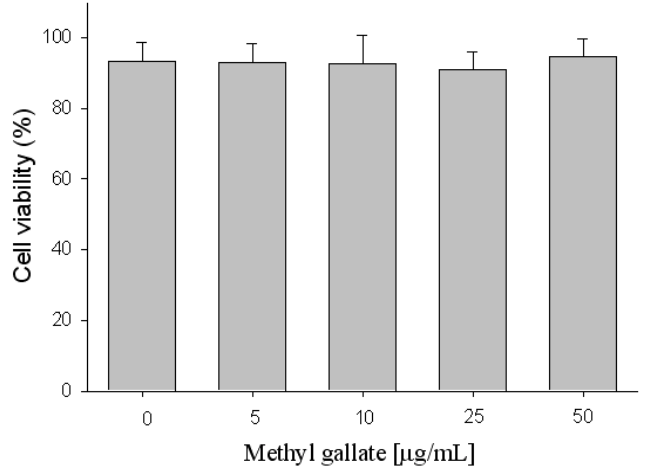
Figure 3. Cell toxicity using the MTT